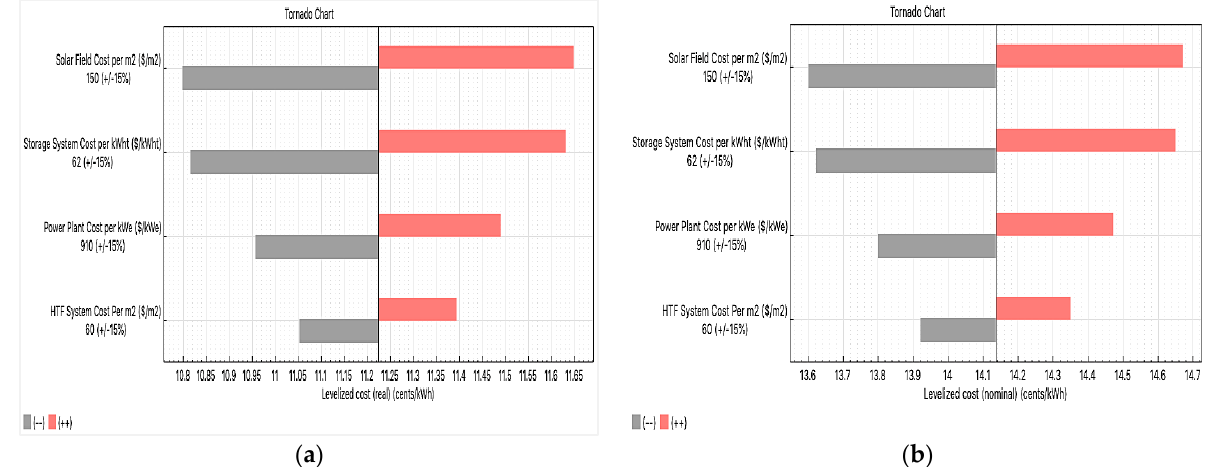
Figure 12. Effects of financial parameter uncertainties on LCOEs: ( a ) real LCOE and ( b ) nominal LCOE.